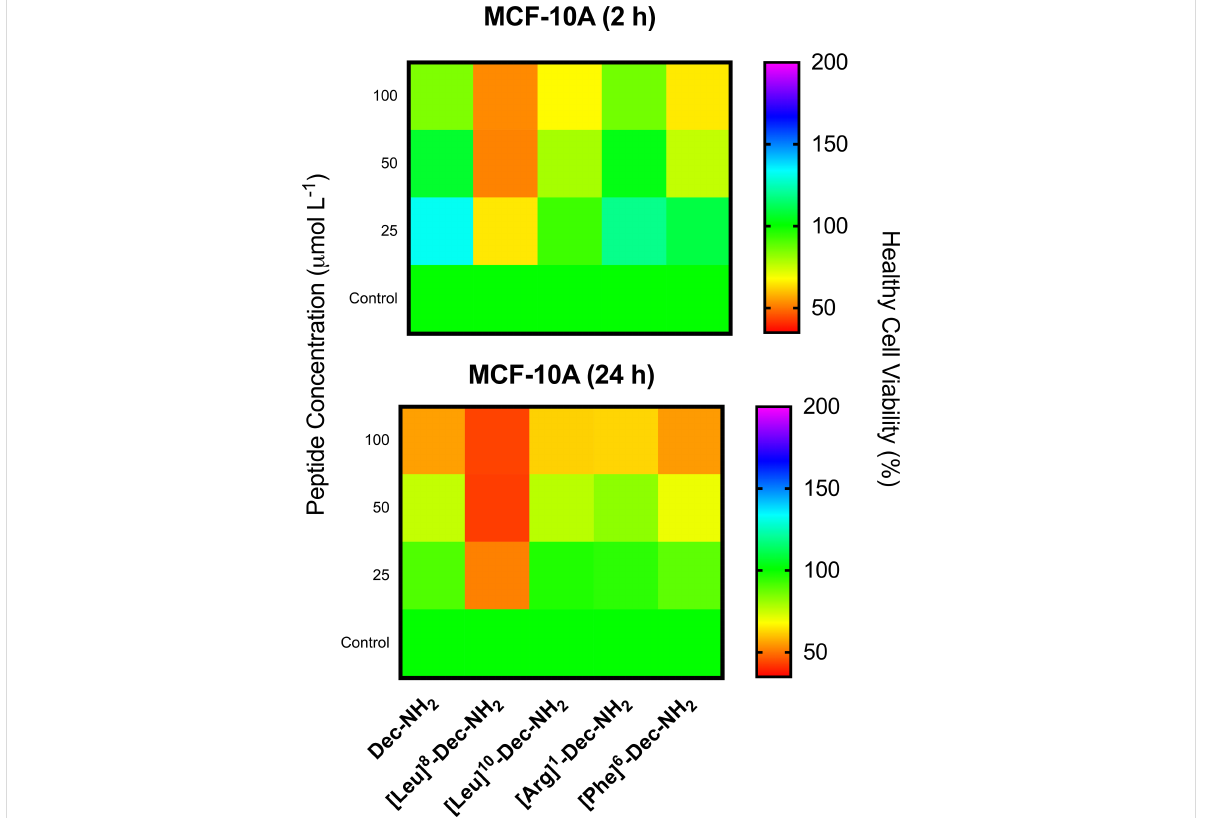
Figure 3: MTT assays evaluating the toxicity of Dec-NH 2 and its derivatives towards MCF-10A normal cells after 2 and 24 h. Experiments were per- formed in triplicate.